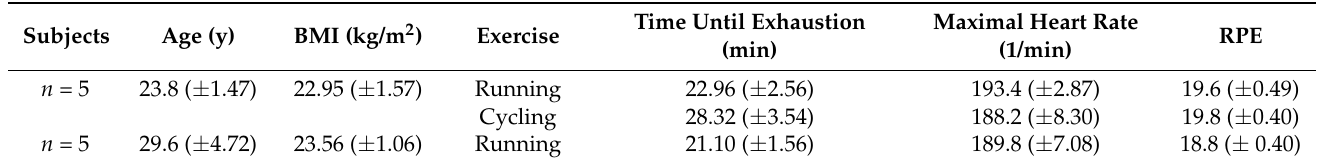
Table 1. Participants characteristics and exercise performance. Values are given in mean ( ± SD). BMI = body mass index, RPE = rating of perceived exertion (values between 6 and 20 are